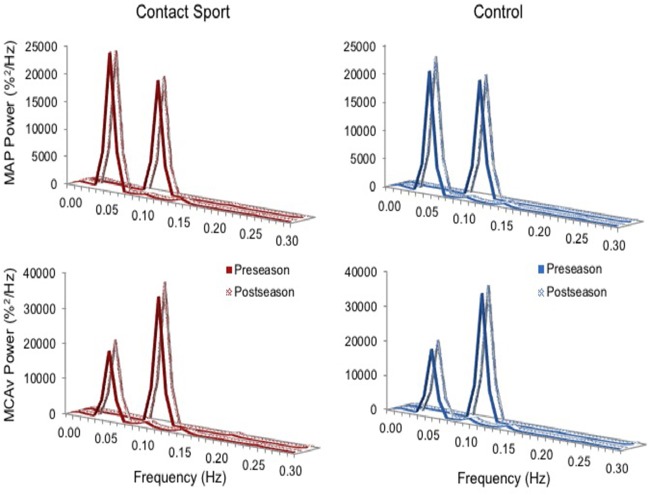
Normalized power spectrum densities for mean arterial pressure (MAP, top) and middle cerebral artery blood velocity (MCAv, bottom) for preseason and post-season squat-stands in contact sport athletes (red, left) and in non-contact sport control athletes (blue, right). The frequency at which PSD reached peak amplitude (either 0.05 or 0.10 Hz) was used for sampling point estimates for Coherence, Phase, and Gain.